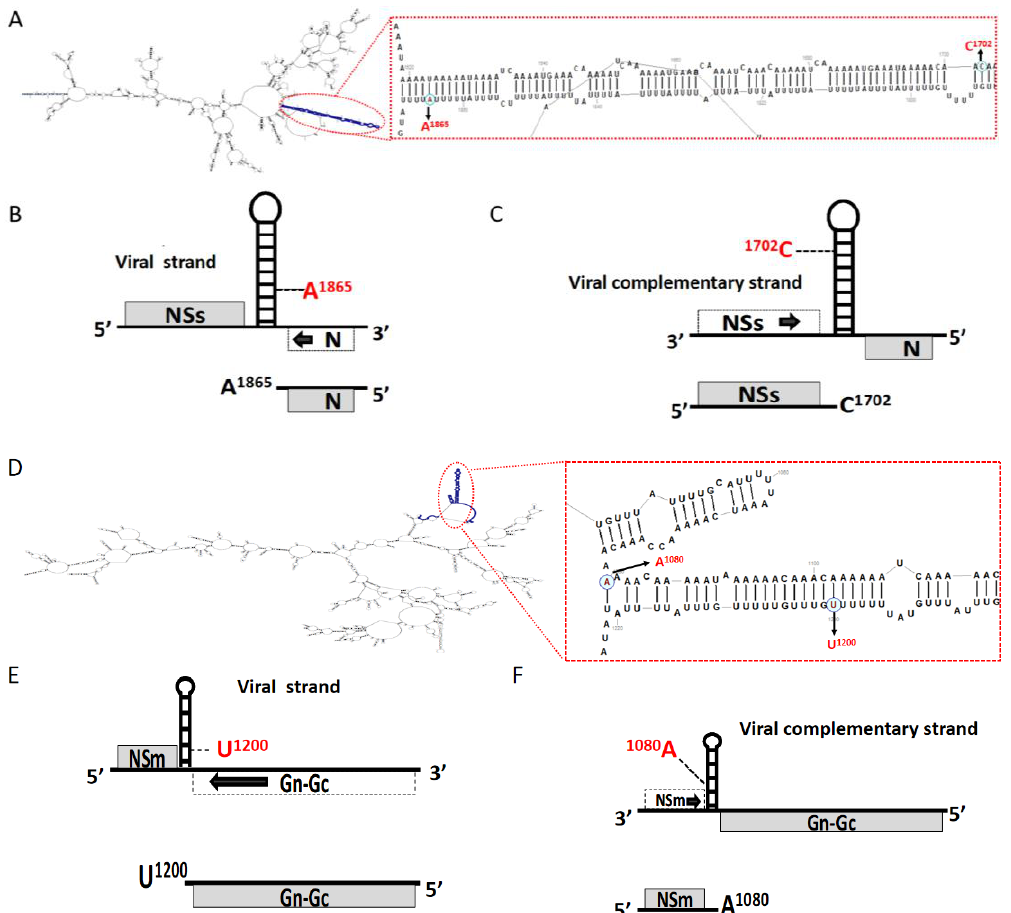
Figure 2. Location of 3 (cid:48) terminal nucleotide of sgRNAs within the intergenic regions (IGR) of RNA M and RNA S as well as their compliment strands. ( A ) Predicted secondary structure of TSWV RNA S genome, broken circle indicating the stem-loop in the IGR. ( B ) Organization of sgRNA-N and location of 3 (cid:48) terminal nucleotide on the stem-loop. ( C ) Organization of sgRNA-NSs and location of 3 (cid:48) terminal nucleotide on the stem-loop. ( D ) Predicted secondary structure of TSWV RNA M genome, broken circle indicating the stem-loop in the IGR ( E ). Organization of sgRNA-(Gn-Gc) and location of 3 (cid:48) terminal nucleotide on the stem-loop. ( F ) Organization of sgRNA-NSm and location of 3 (cid:48) terminal nucleotide on the stem-loop.